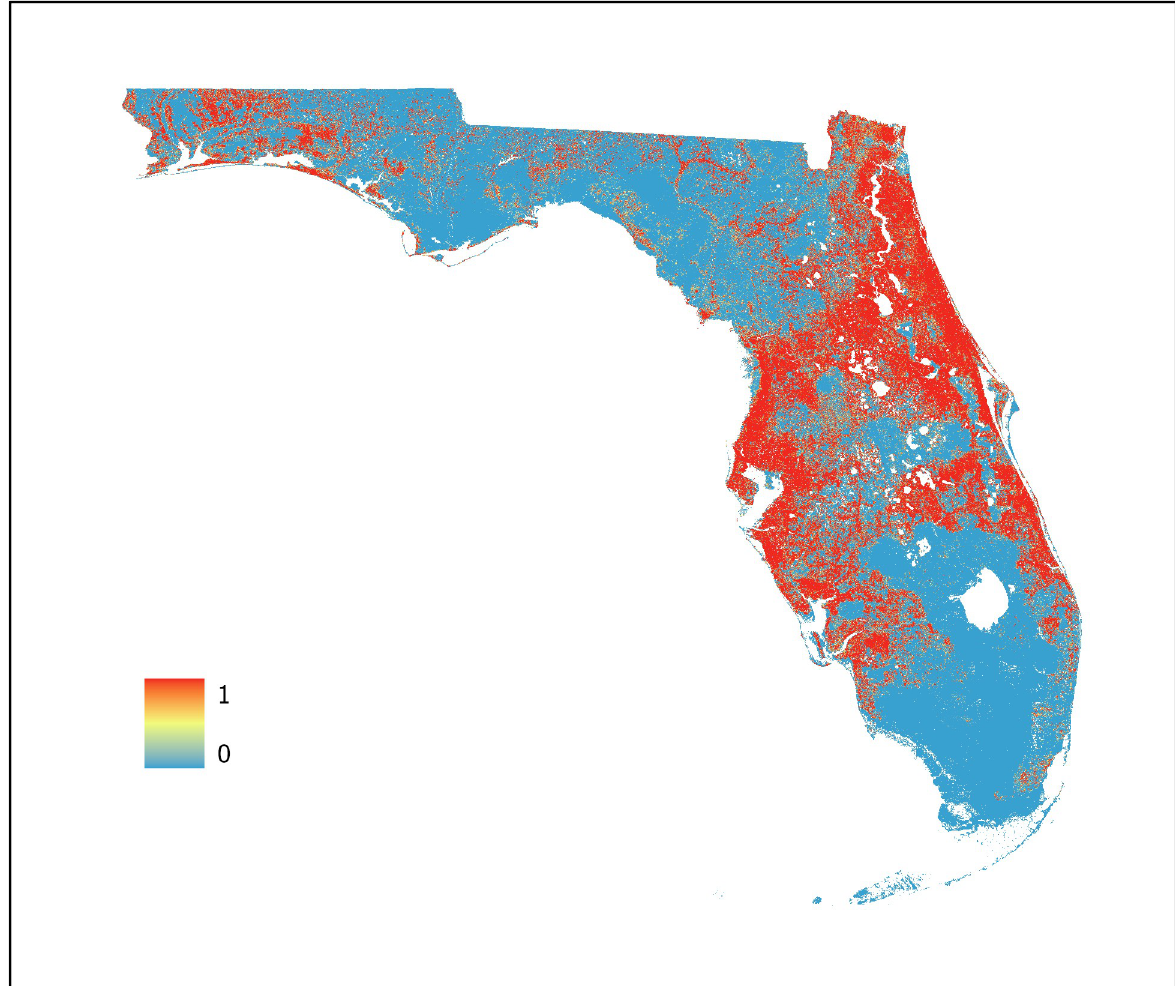
Fig 7. Boosted regression tree model. Predictive values range from 0 to 1 with an AUC of 0.986 (95% CI